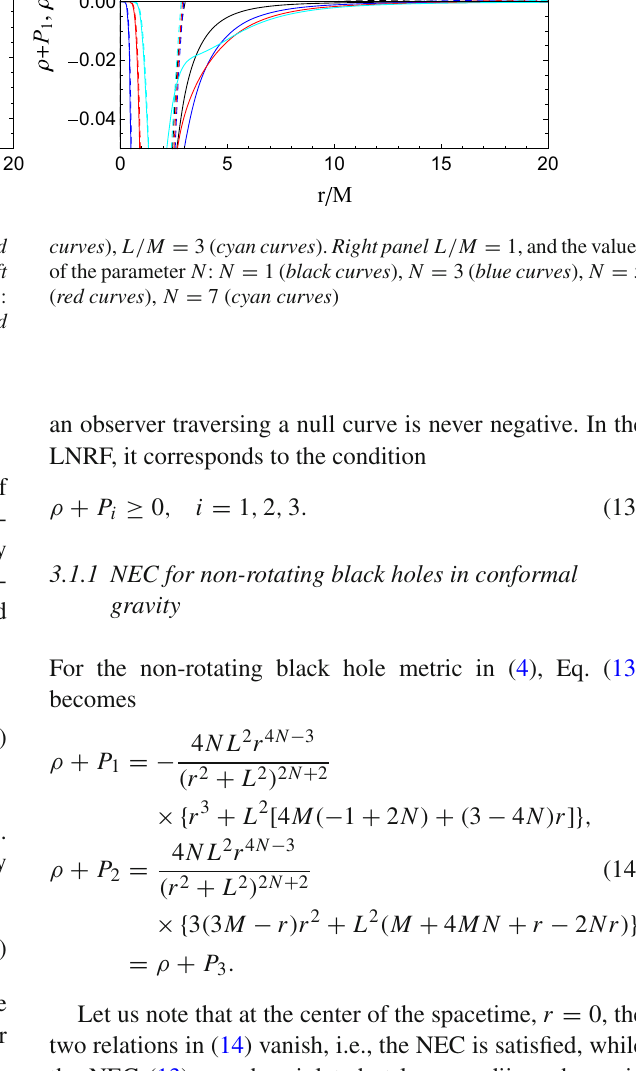
curves ), L / M = 3 ( cyan curves ). Right panel L / M = 1, and the values of the parameter N : N = 1 ( black curves ), N = 3 ( blue curves ), N = 5 ( red curves ), N = 7 ( cyan curves